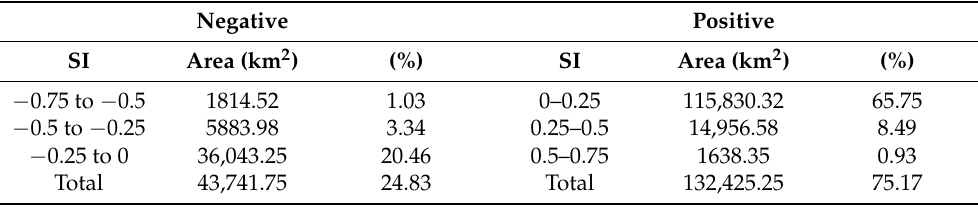
Figure 6. Map of sensitivity index (SI) under climate change. Table 3. Statistics of sensitivity index (SI) under climate change.